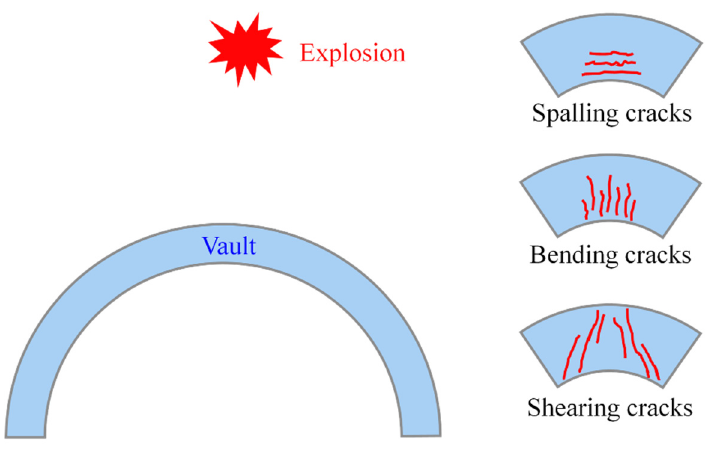
Figure 1. Common damages of RC arch structures subjected to the explosion [5].